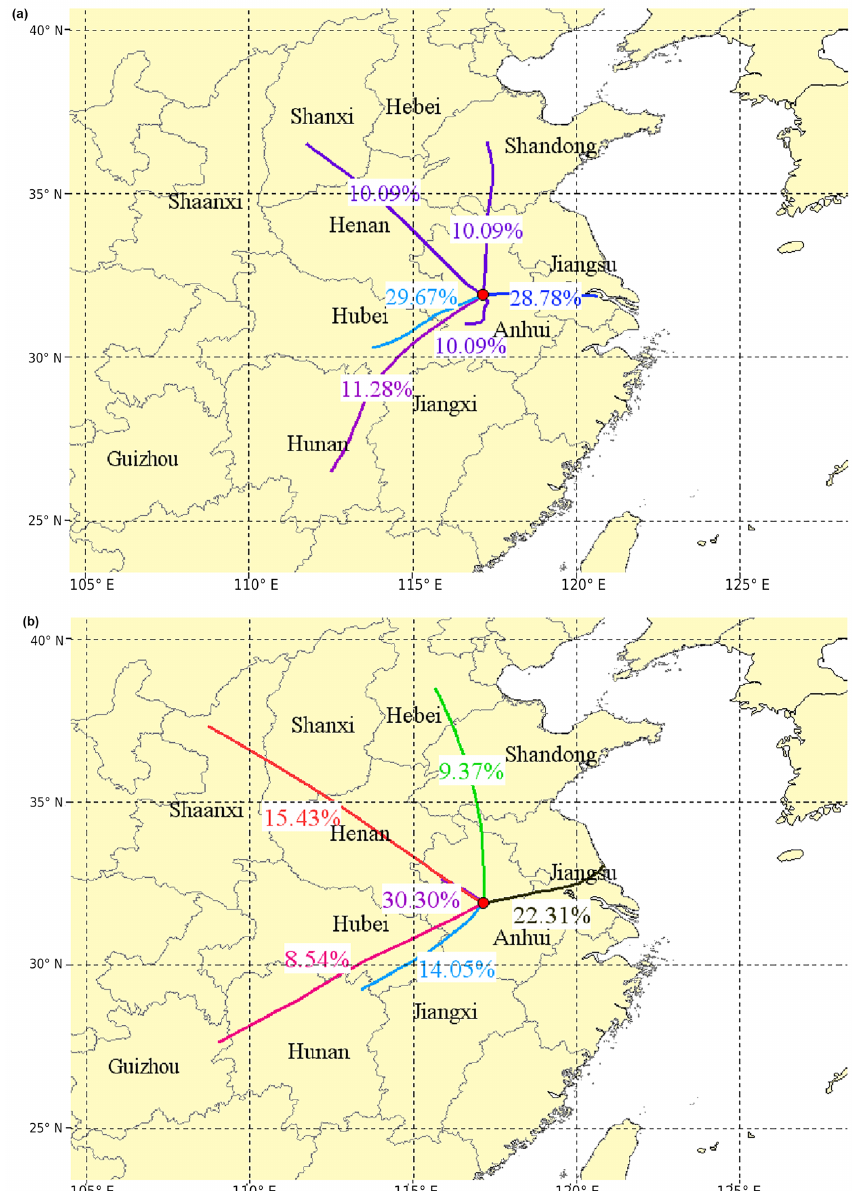
Figure 2. One-day HYSPLIT back trajectory clusters arriving at Hefei at 1500ma.s.l that are coincident with the FTS measurements from 2014 to 2017. (a) Spring and summer (MAM/JJA) and (b) Autumn and winter (SON/DJF) season. The base map was generated using the TrajStat 1.2.2 software (http://www.meteothinker.com, last access: 23 May